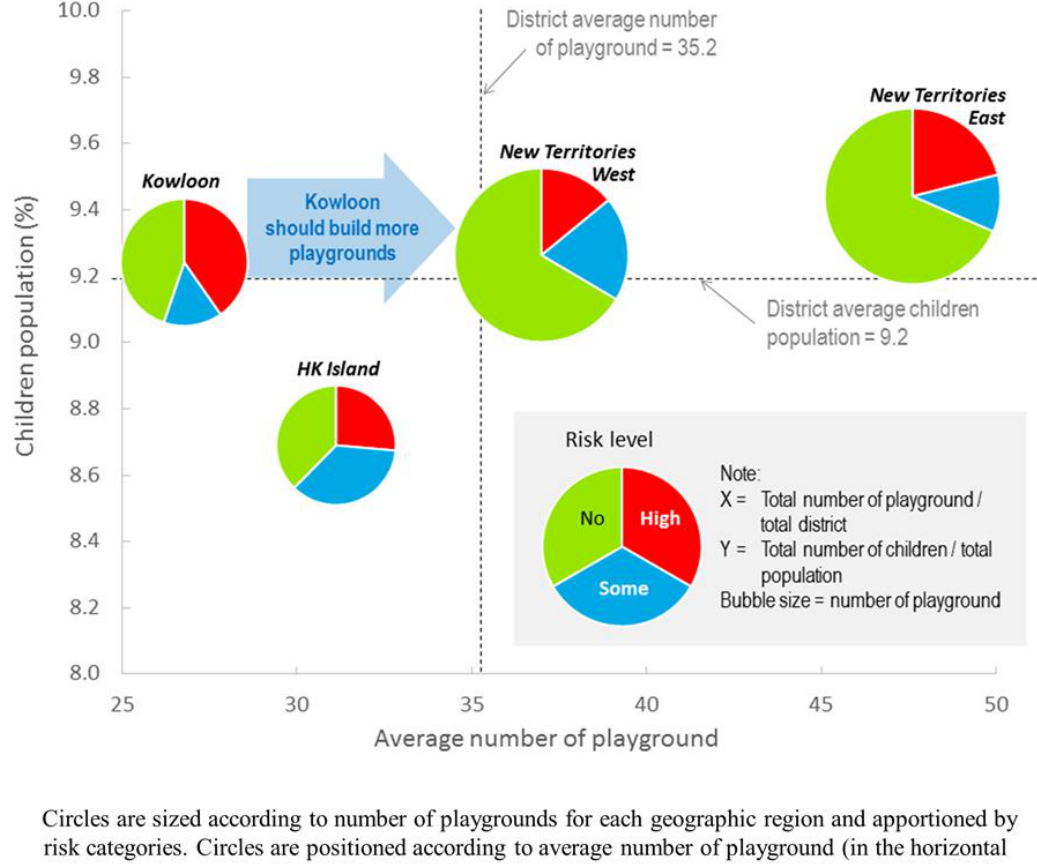
Figure 5. Playgrounds by risk levels by regions of Hong Kong against average number of playground and percent children population, 2016.